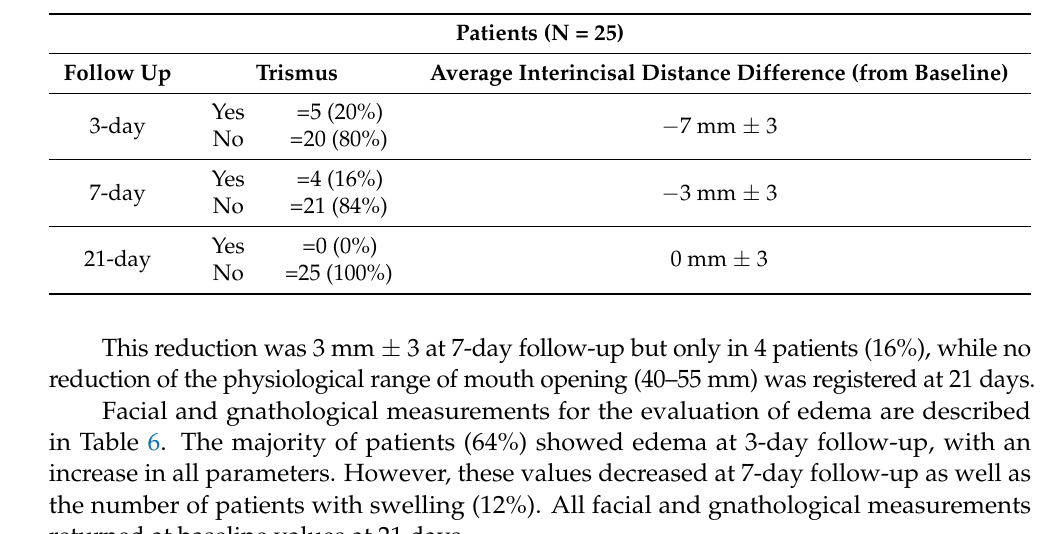
Table 5. Average interincisal distance difference from baseline.